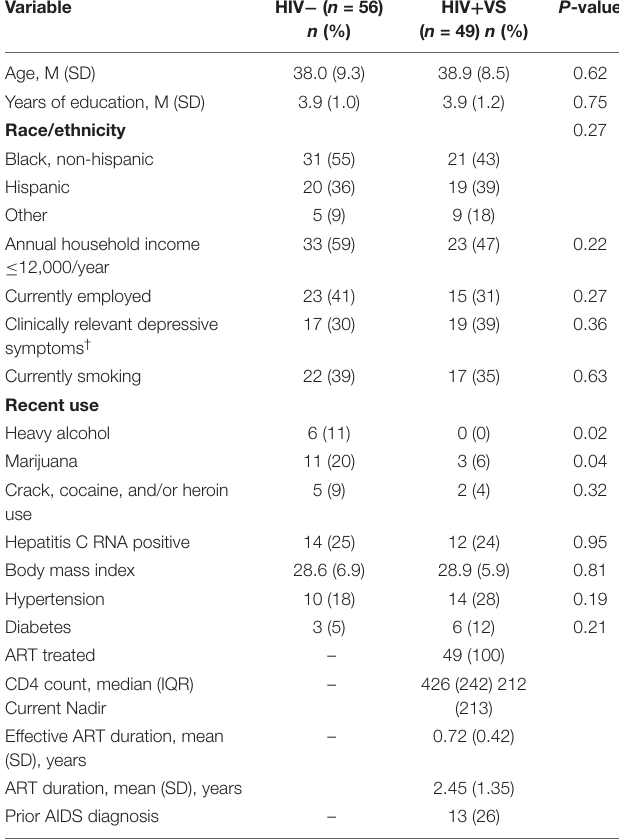
TABLE 1 | Demographic, behavioral, and clinical characteristics at the initial visit when immune makers were assessed among HIV-uninfected (HIV-) women and virally suppressed women with HIV (HIV +